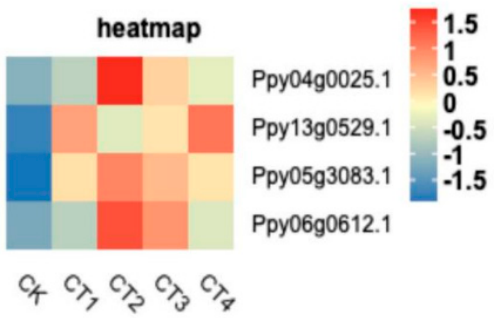
Figure 8. Heat map of DEGs enriched in the flavonoid biosynthesis pathway. Blue and red indicate low and high gene expression levels, respectively.